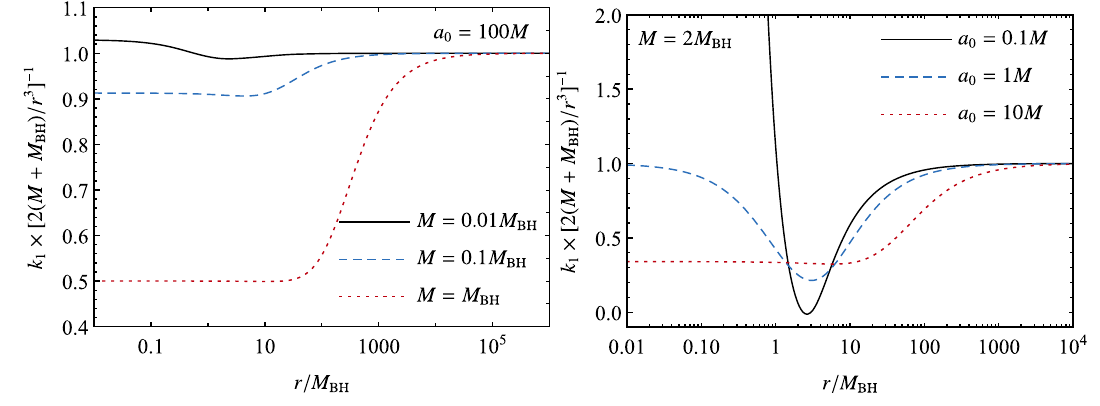
Fig. 8 Normalizedtidaltensorcomponent k 1 ,forBHswithanisotropic matter, as a function of the radius, for some representative cases. In the left panel we fix a 0 = 100 M , considering different values for the mass